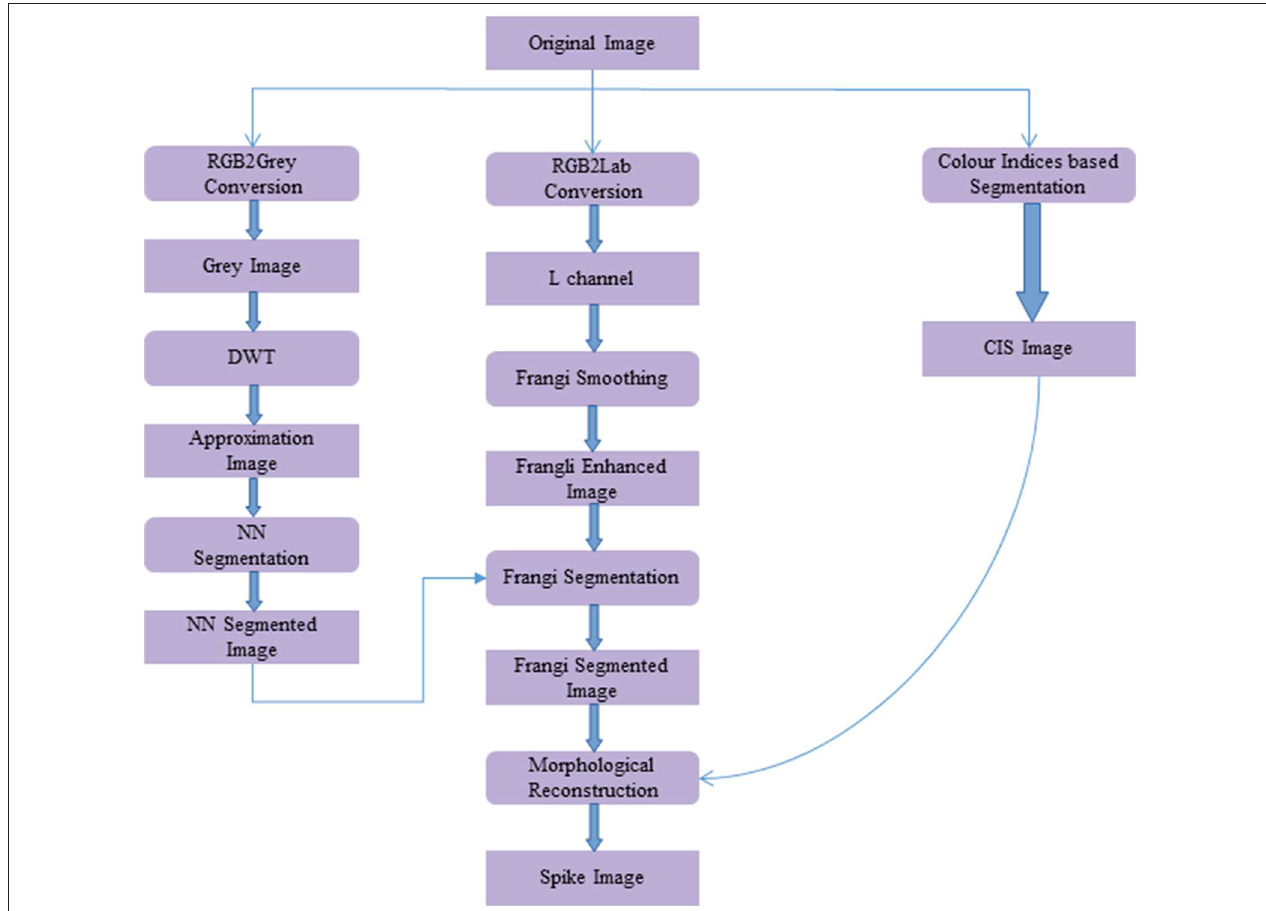
FIGURE 2 | Workflow of the proposed spike detection algorithm using image processing methods. Framed rectangles represent the data modalities, and other rectangles describe the image processing